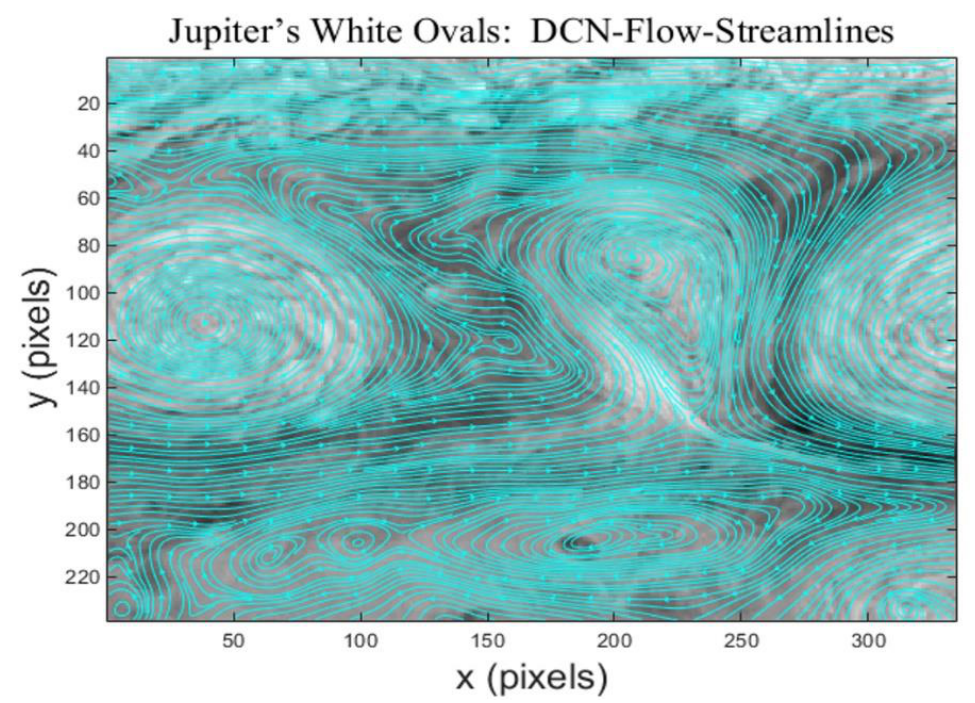
Figure 17. The predicted streamlines by our method for Jupiter’s White Ovals.